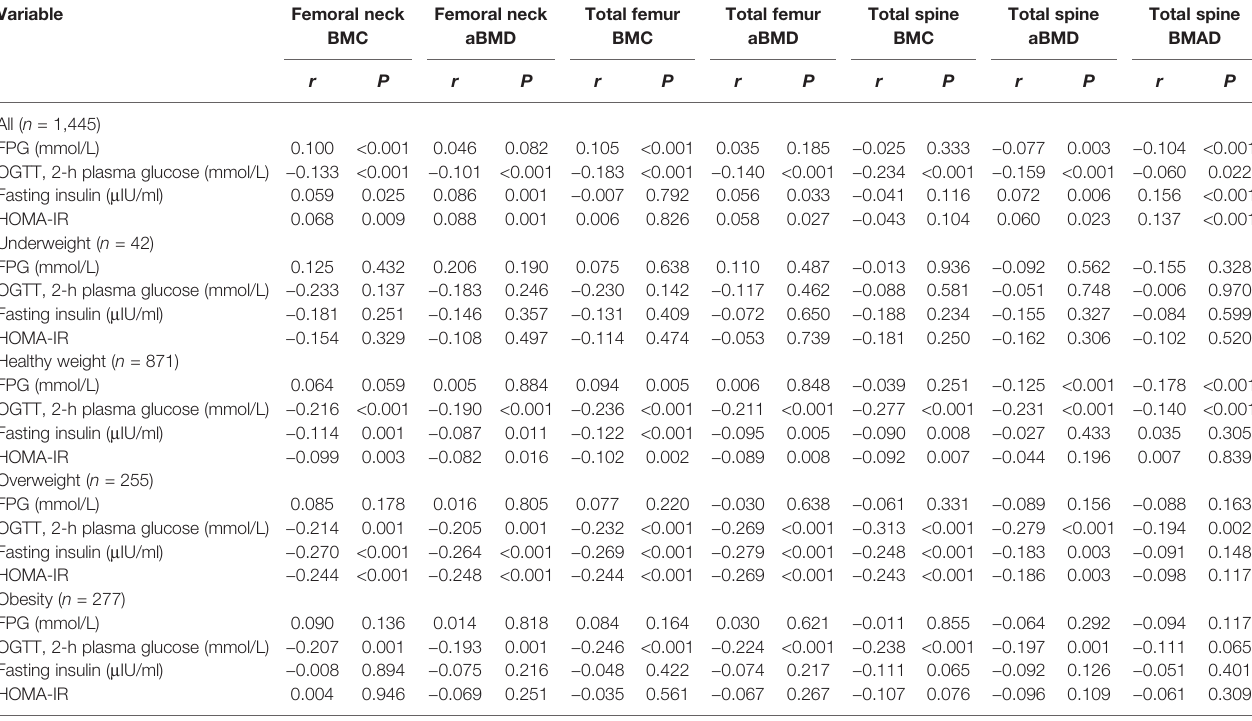
BMC, bone mineral content; aBMD, areal bone mineral density; BMAD, bone mineral apparent density; FPG, fasting plasma glucose; OGTT, oral glucose tolerance test; HOMA-IR, homeostasis model assessment insulin